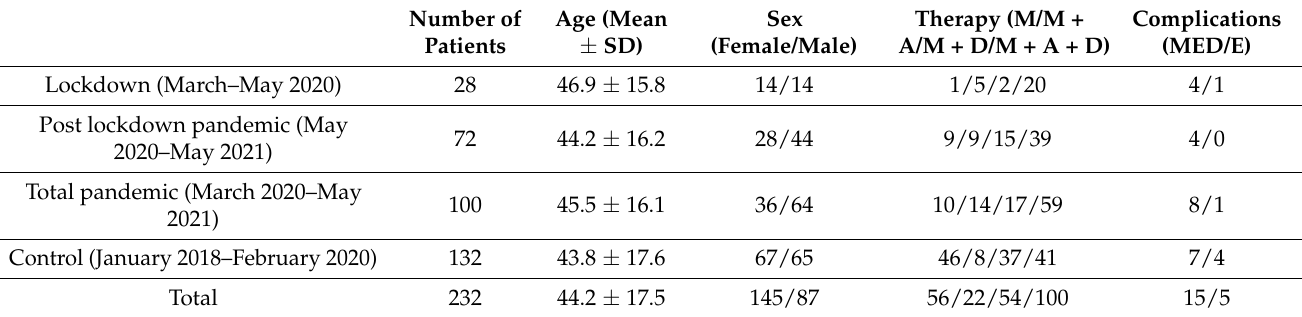
Table 2. Demographic characteristics of the study population. SD: standard deviation; M: medical therapy—see text; A: tooth extraction; D: intraoral/percutaneous drainage; E: exitus; MED: mediastinitis.